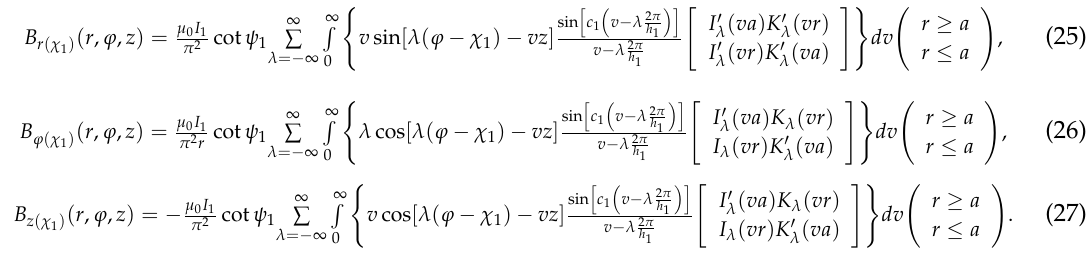
Figure 3. The width of the tape conductor is D 1 , and the angular coordinates of the intersections in which the two boundary lines intersect with the z = 0 plane are α 1 and − α 1 ,